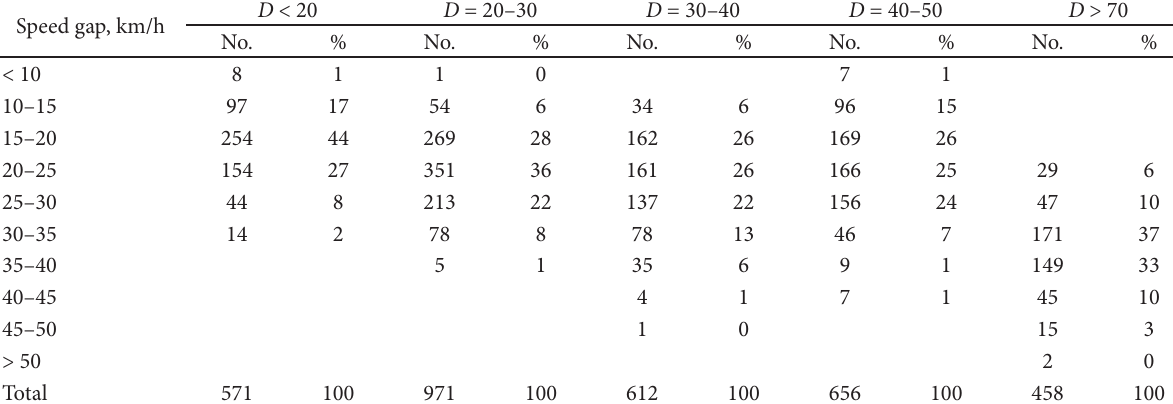
Table . Speed distribution on roundabouts